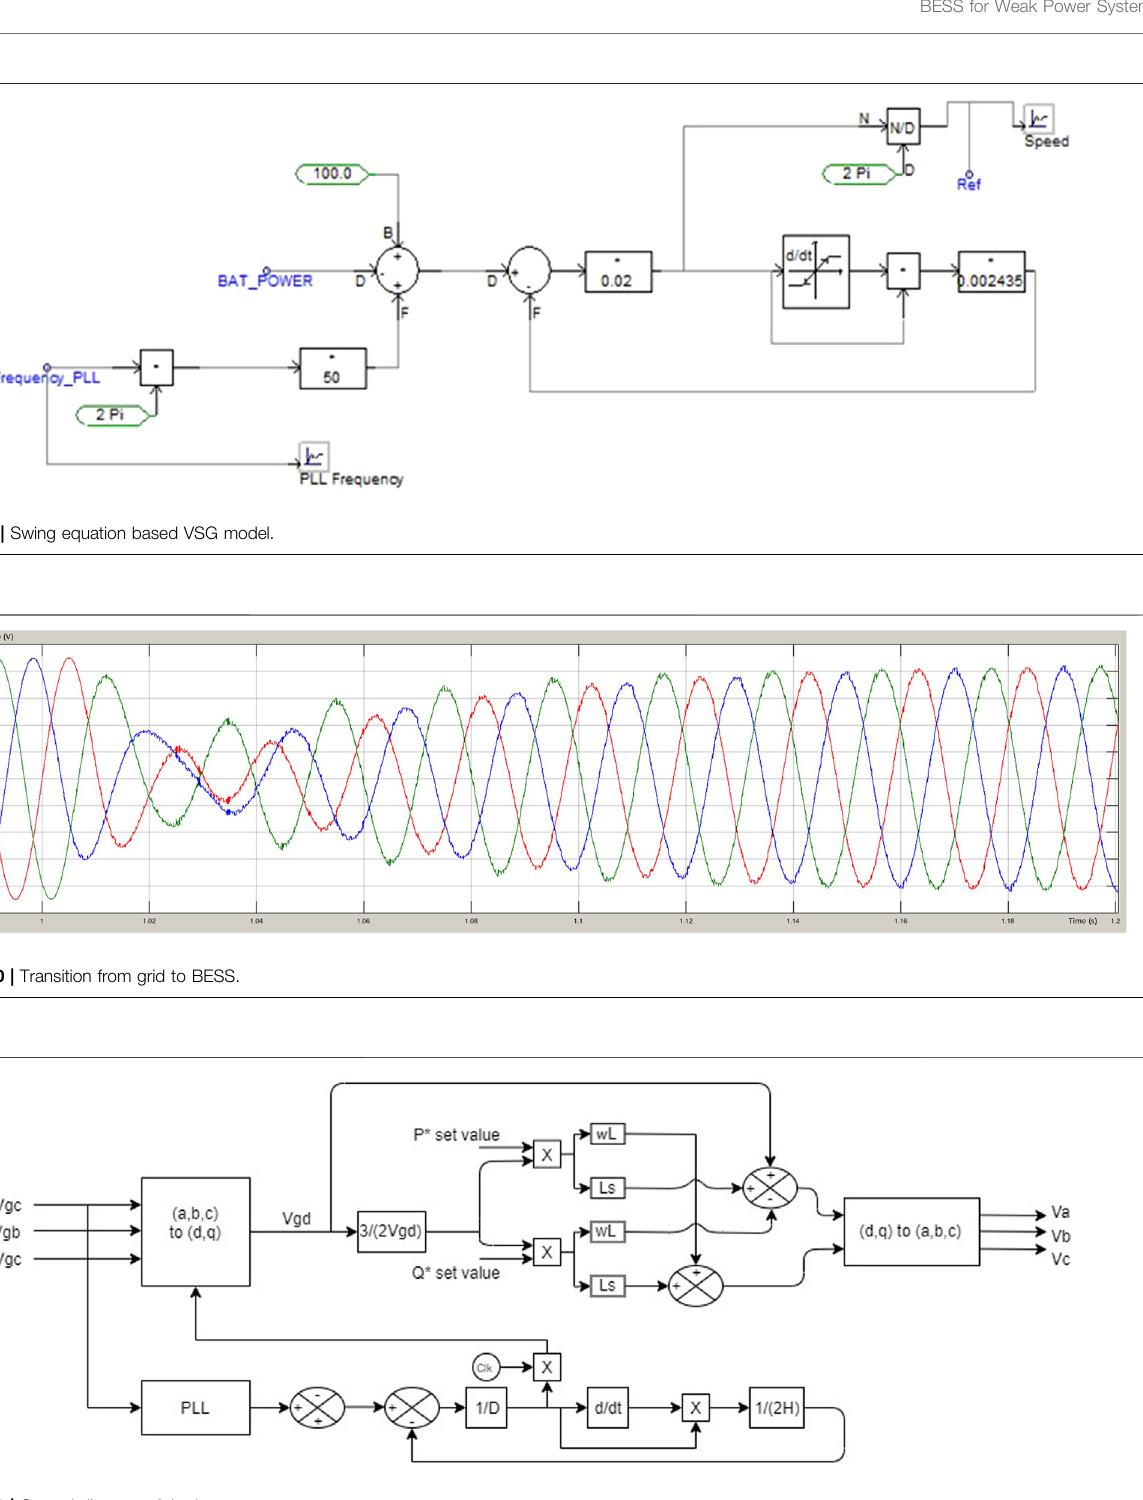
FIGURE 11 | Control diagram of the